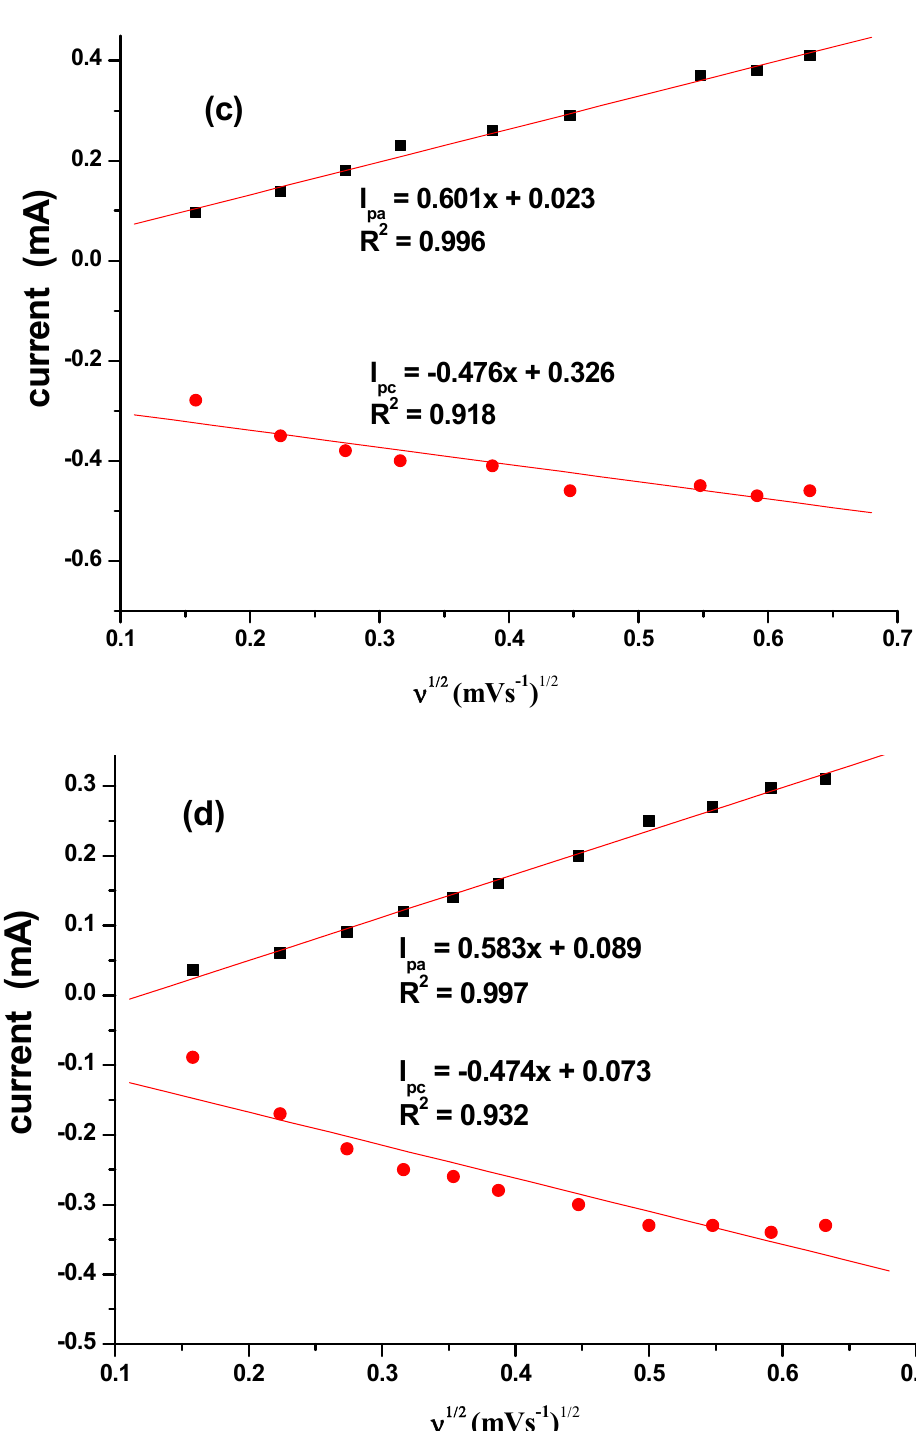
Figure 9. Corresponding linear plots of V 1/2 versus currents for ( a ) SPC/cCuO, ( b ) SPC/wCuO, ( c ) SPC/aCuO and ( d ) SPC/eCuO varying scan rates (50–400 mV/s).